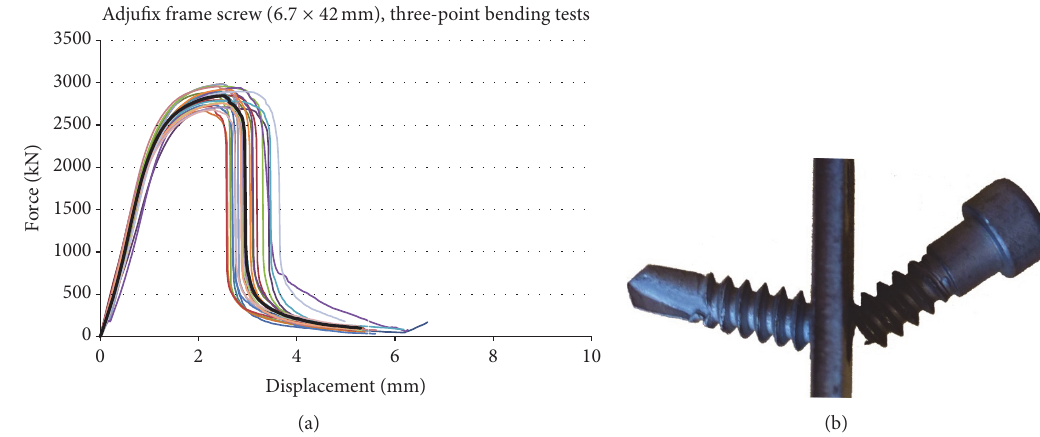
Figure 10: (a) Load-slip curves from 26 three-point bending tests of the Adjufix frame screw (6.7 × 42 mm) (the solid curve is the mean curve) and (b) photo of the screw after